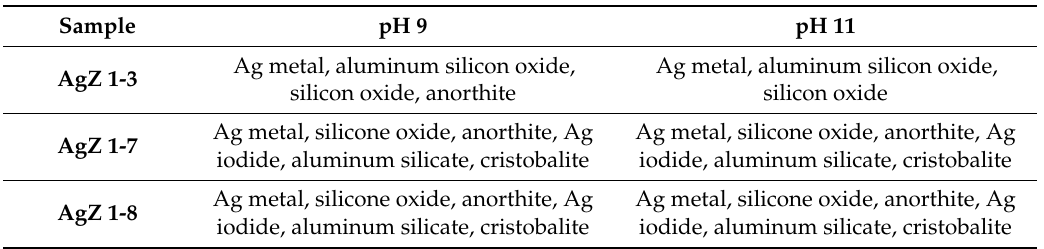
Table 4. Summary of the crystalline phases measured with XRD following SPFT AgZ tests at pH 9 and pH 11.